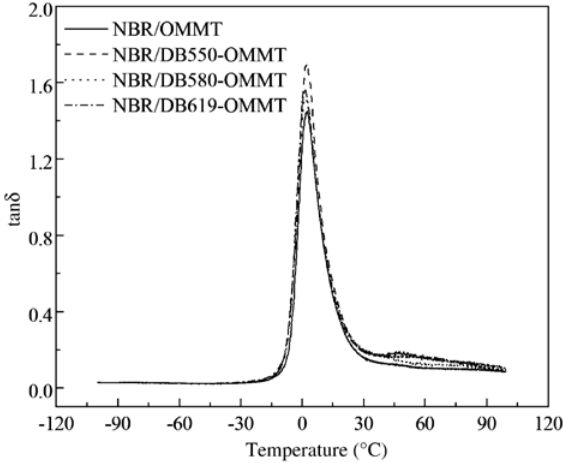
Figure 7 Different kinds of organophilic montmorillonite loading on the tan δ